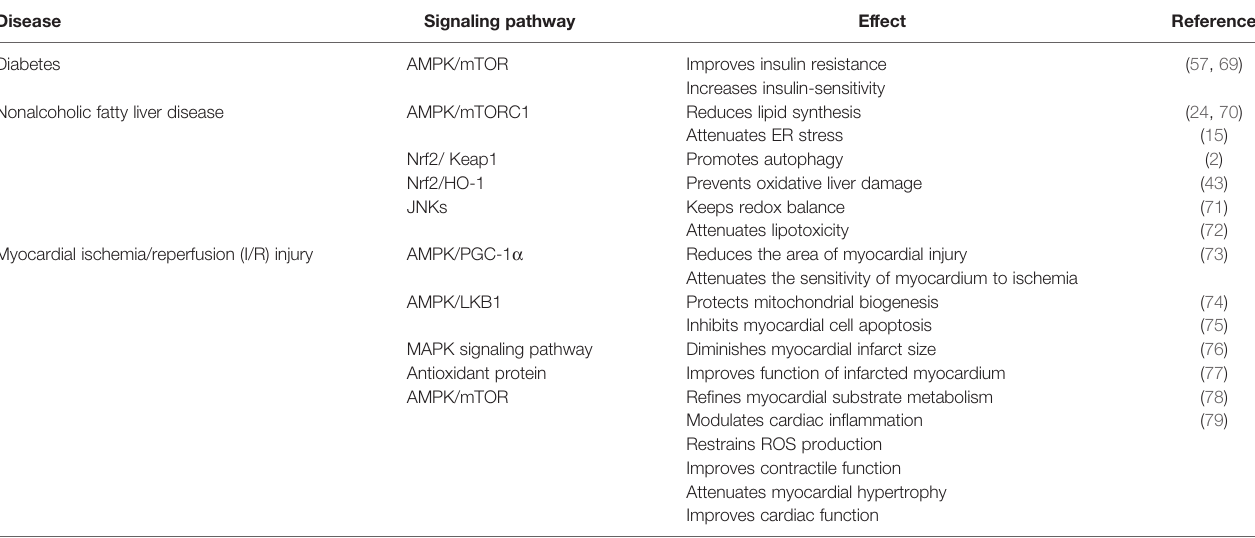
TABLE 1 | Summary of the role of Sestrin2 in metabolic diseases.